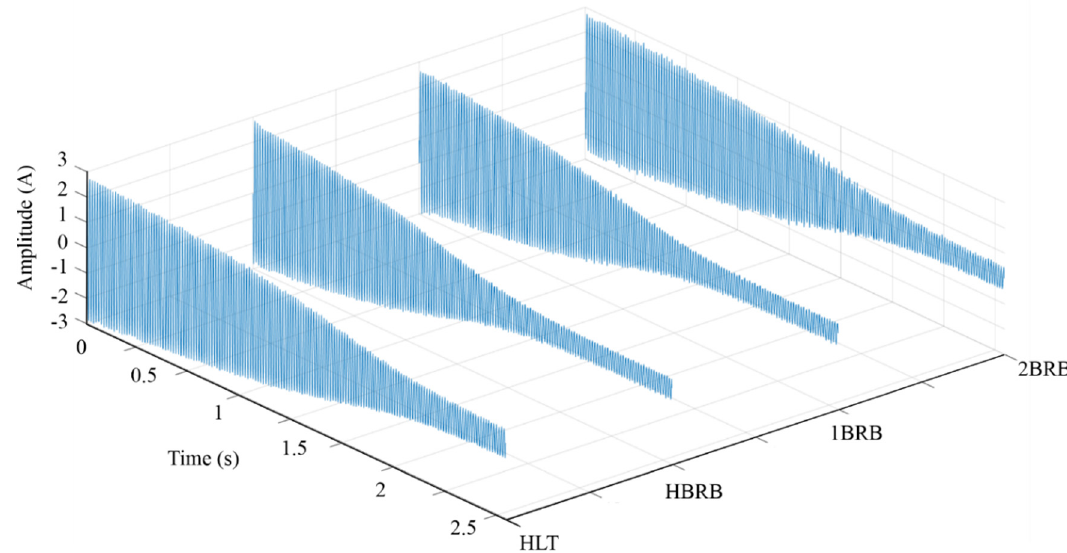
Figure 9. Current signals during the startup transient for HLT, HBRB, 1BRB, and 2BRB conditions.